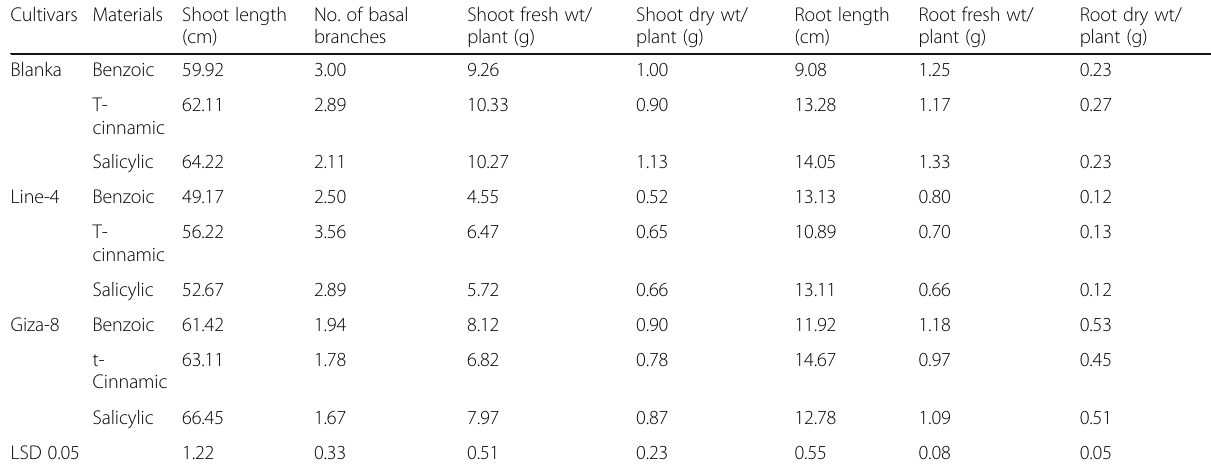
highest seed yield (723.73 kg/fed), biological yield (3.880 ton/fed), seed yield/plant (6.09 g), and plant height (88.66 cm) were obtained at 100 mg/l salicylic acid. Meanwhile, foliar treatment with benzoic acid at 75 mg/l was the most effective treatment in fruiting zone length (33.67 cm), technical length (53.44 cm), biological yield/ plant (17.01 g), number of capsules/plant (101.70), and 1000 seeds weight (9.45 g) in addition to oil% (25.09%) and carbohydrate% (30.95%). While 75 mg/l t-cinnamic acid shows the highest number of branches/plant (21).